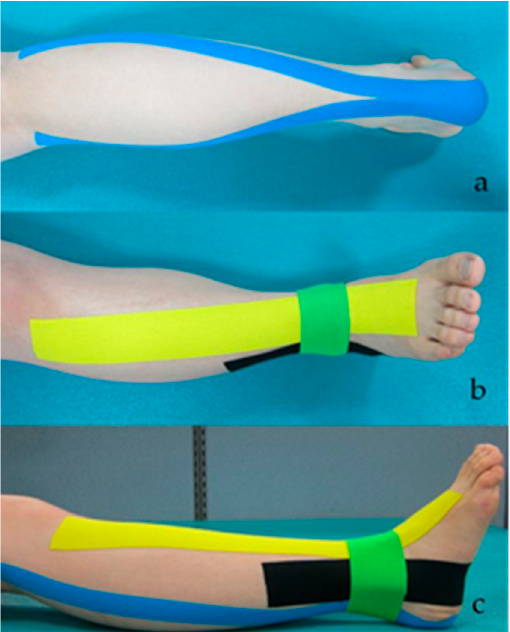
Figure 1. A-KT applied to the gastrocnemius muscle ( a ), tibialis anterior ( b ) and for subtalar ever- sion ( c